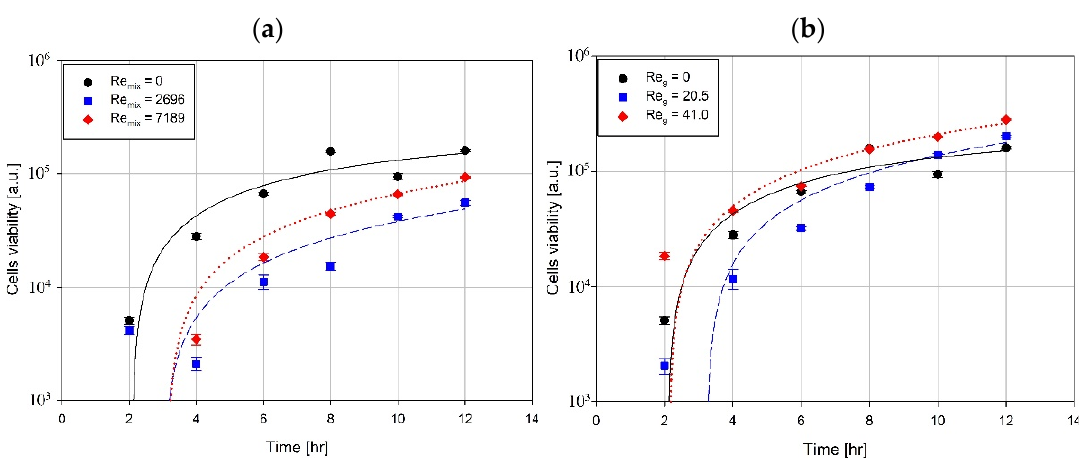
Figure 5. Changes in bacterial cell viability during the process: ( a ) impact of mixing speed, ( b ) impact of aeration.